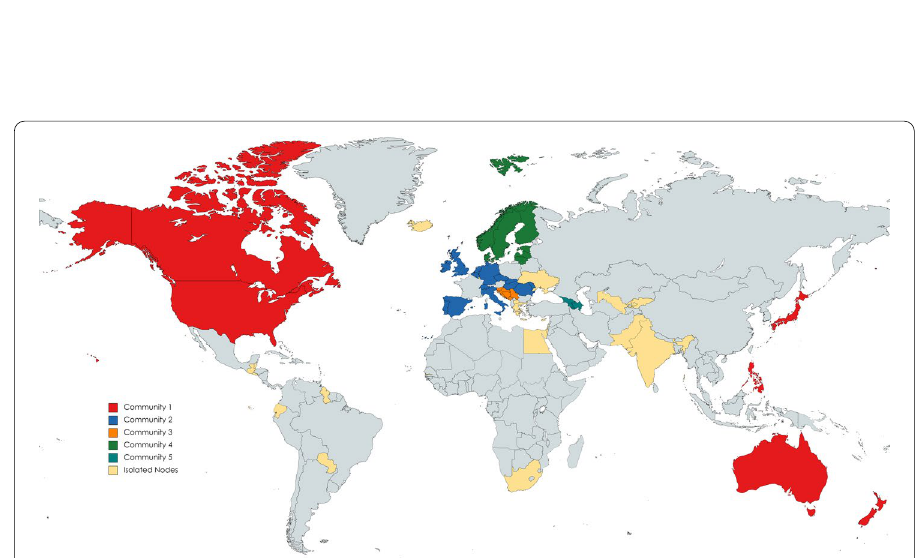
Fig. 2 World map with the optimal community structure in